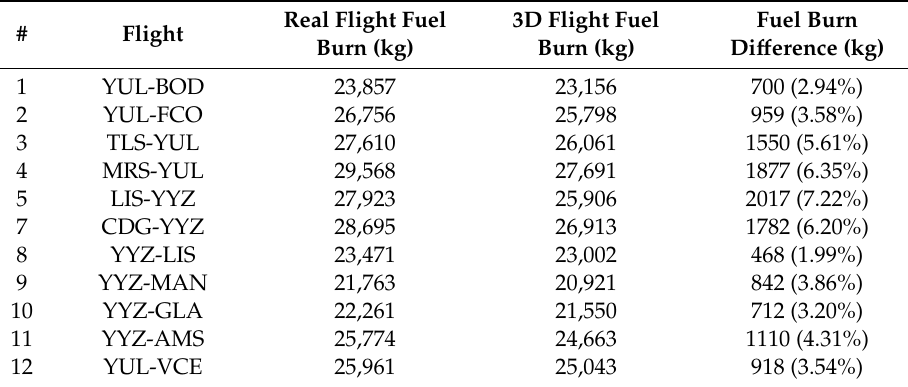
Table 4. Fuel burn comparison for di ff erent as-flown flights.